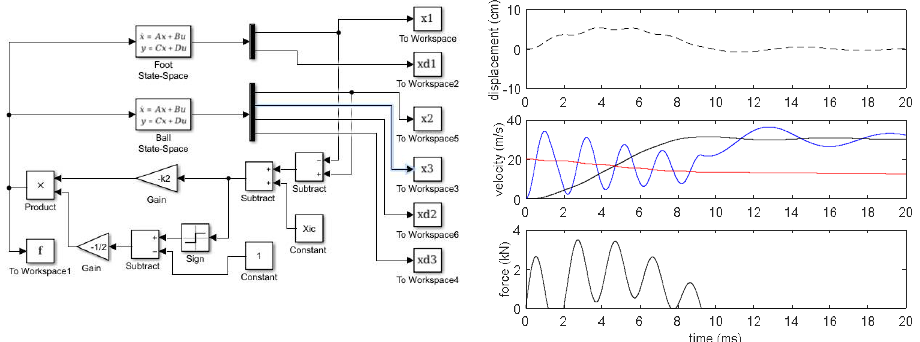
Figure 3. Kicking of football MATLAB Simulink model and resulting plot indicating: deformation of the ball; velocity of foot (red), front (blue) and back (black) of ball; and force of the foot on the